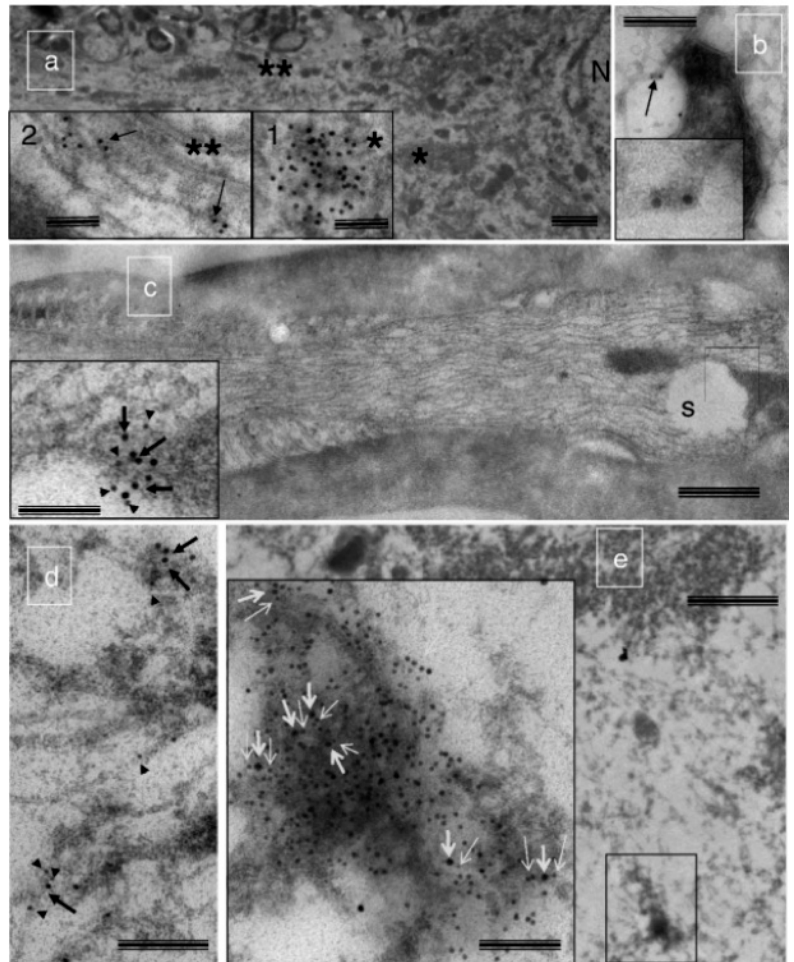
Figure 6. Spinal cord motoneuron soma have activated caspase 3, and activated caspase 3 is found to be associated with the axonal microtubules and the retrograde transport protein dynein, suggesting retrograde transport of activated caspase 3 from motoneuron terminals occurs with aging. Panel ( a ) shows immunogold-labeled activated caspase 3 in close proximity to the nucleus of the motoneuron soma, and associated with the microtubules in the axon hillock in aged rat. Panel ( b ) shows activated caspase 3 on vesicle-like structures associated with the microtubules in motoneuron axon. Panel ( c ) shows double immunogold labeling of activated caspase c (10 nm gold particle, arrows) and dynein (5 nm gold particle, arrowheads) in the proximity of a swollen mitochondrion. Panel ( d ) shows colocalization of dynein (arrowheads) and activated caspase 3 (arrows) with axon terminal microtubules. Panel ( e ) shows the soma of a motoneuron from an aged rat with double immunogold labeling of activated caspase 3 and dynein. Inset shows a magnified view co-localized dynein (thin arrows) with activated caspase 3 (thick arrows). * = caspase 3 immunoreactive spots; ** = caspase 3 associated with microtubules in the axon hillock. Figure reproduced from [47] with permission.